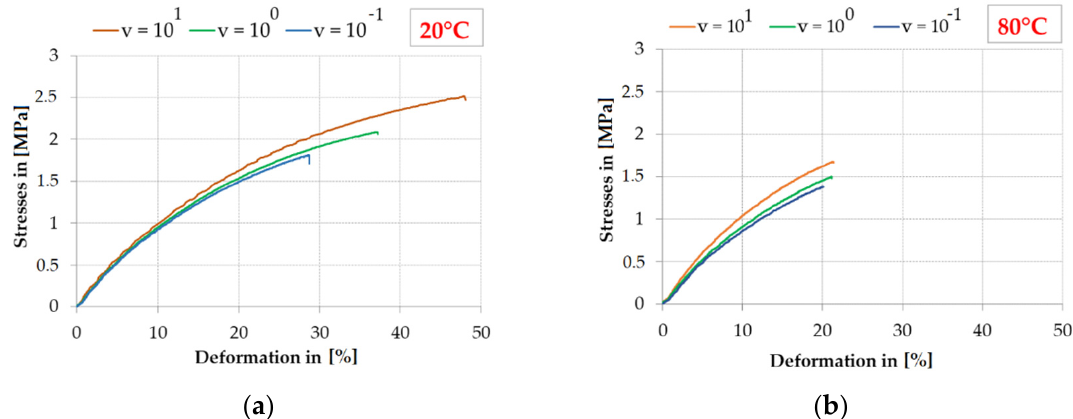
Figure 5. Impact of the test speed on the stress and limit deformation for selected representative specimens of PS adhesive: ( a ) at 20 °C; ( b ) at 80 °C.